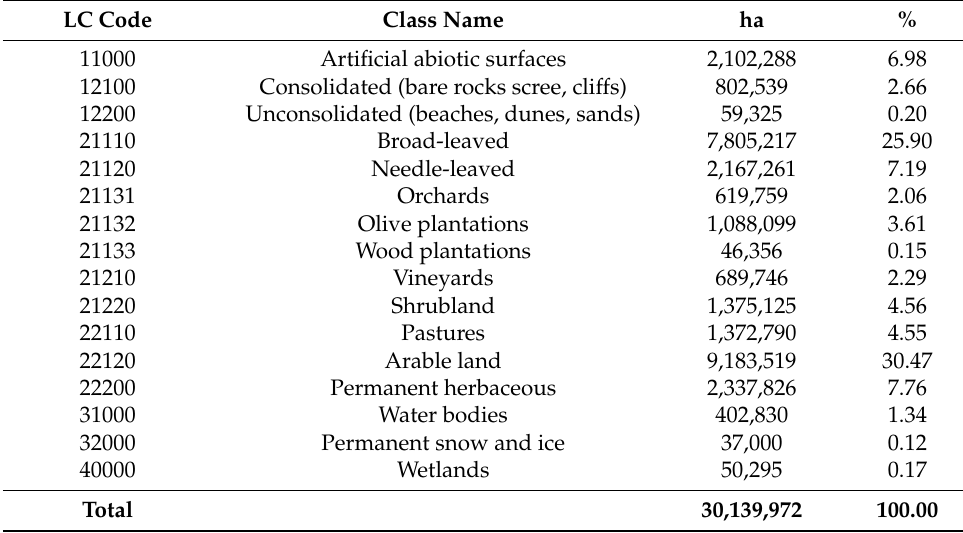
Table 12. Land cover classes 2012 (up to fifth classification